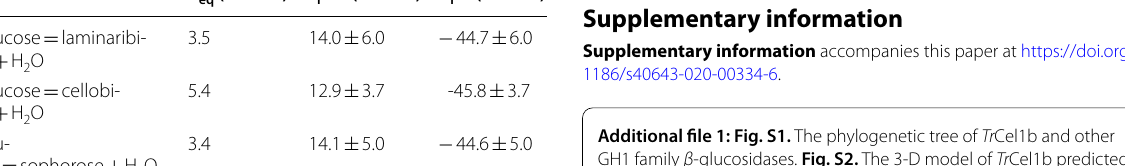
Table 1 Thermodynamic parameters for the reverse hydrolysis from glucose to laminaribiose, cellobiose, and